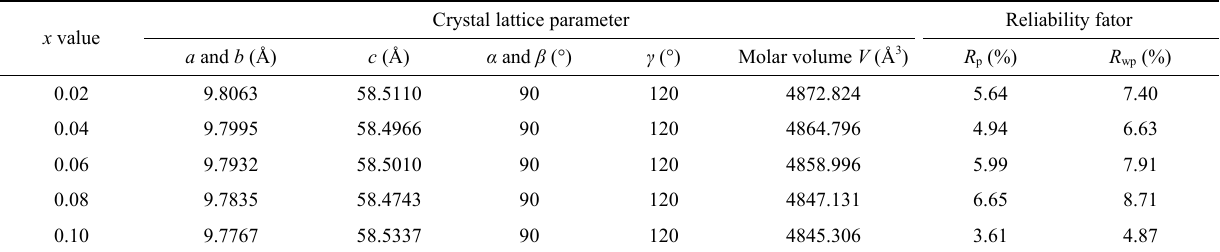
Crystal lattice parameter Reliability